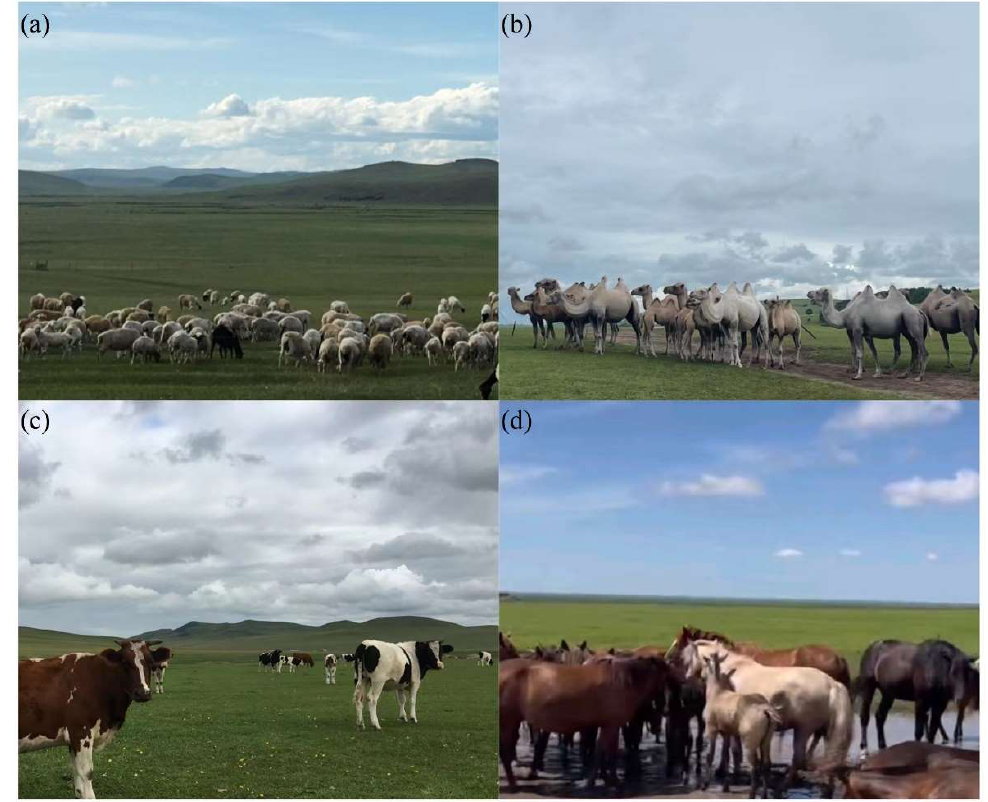
Figure 2. Small livestock ( a ) sheep and large livestock ( b ) camels, ( c ) cattle, ( d ) horses.